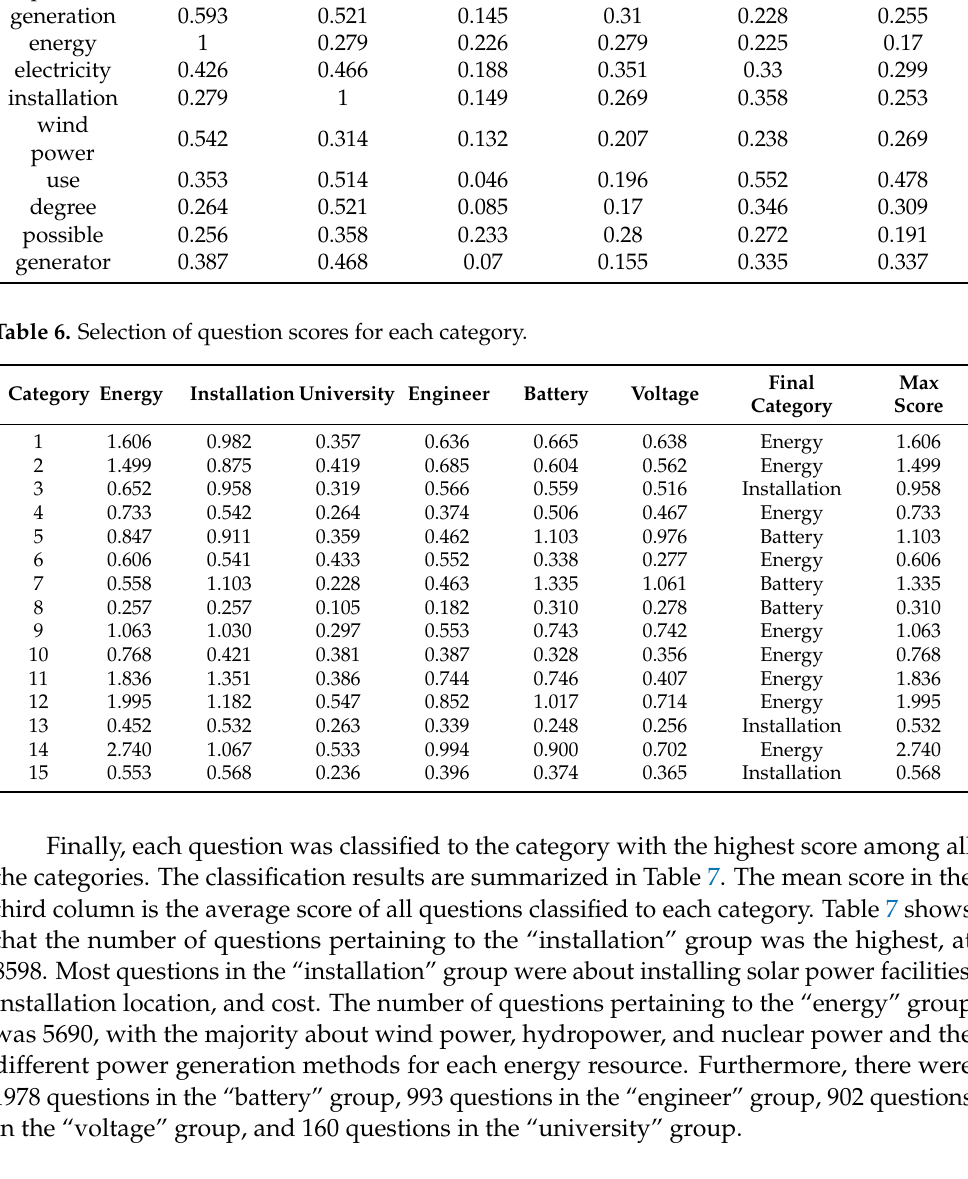
Table 7. Results of classification of questions by